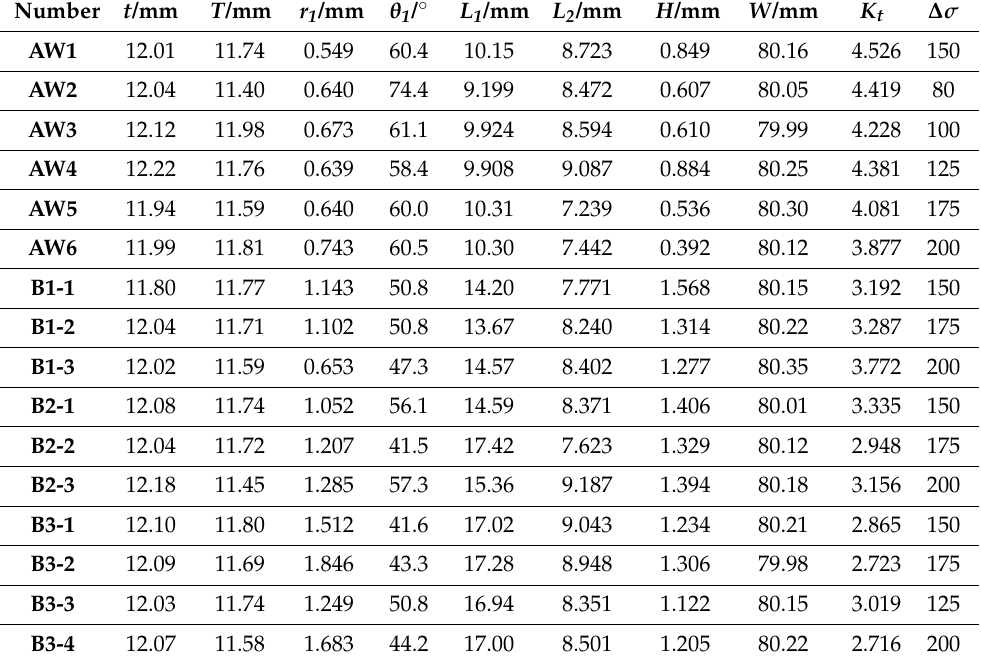
Table 4. Geometric parameters of specimens and loading